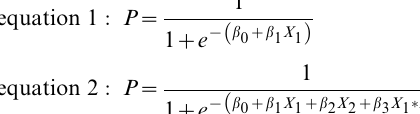
Table S1 Probability values for the comparison of proliferative responses to ffLVS by PBMC from naı¨ve individuals (nv), vaccinees (vc) and patients (p). Table S2 Probability values for the comparison of the antigen-dependent increase (0–0.1 cfu ffLVS/PBMC) in cytokine levels secreted by PBMC from naı¨ve individu- als (nv, 11–13 donors), vaccinees (vc, 11–15 donors) or patients (p, 14–15 donors). Tables S3A–S3F Parameters for Clust semi-automated gating. Table S3A: Parameters for logicle transformation. Table S3B: Parameters for ‘tmixFilter’ object for clustering live cells. Table S3C: Parameters for ‘tmixFilter’ object for clustering CD3 + cells. Table S3D: Parameters for ‘tmixFilter’ object for object for clustering CD3 + CD8 + . Table S3F: Lower and upper boundaries for gating multifunctional